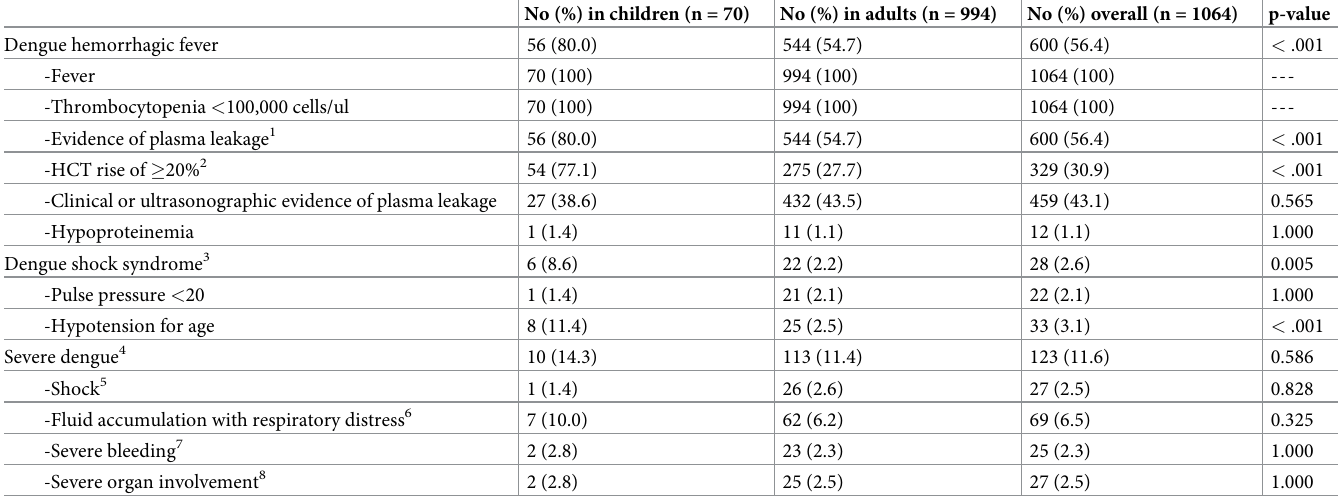
Table 3. Primary clinical outcomes, as defined by the 1997 and 2009 World Health Organization classification criteria for dengue, among children and adults with acute dengue in Southern Province, Sri Lanka, 2017–2018.